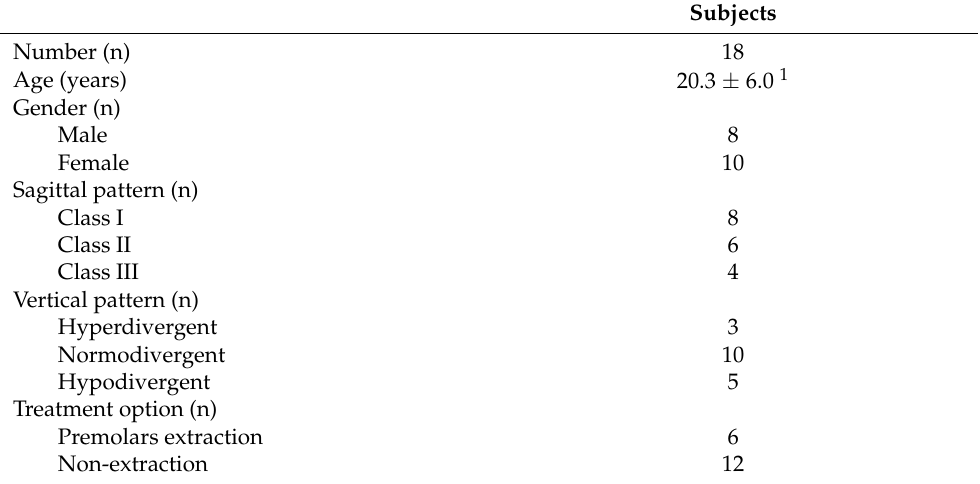
Table 1. Demographic data of